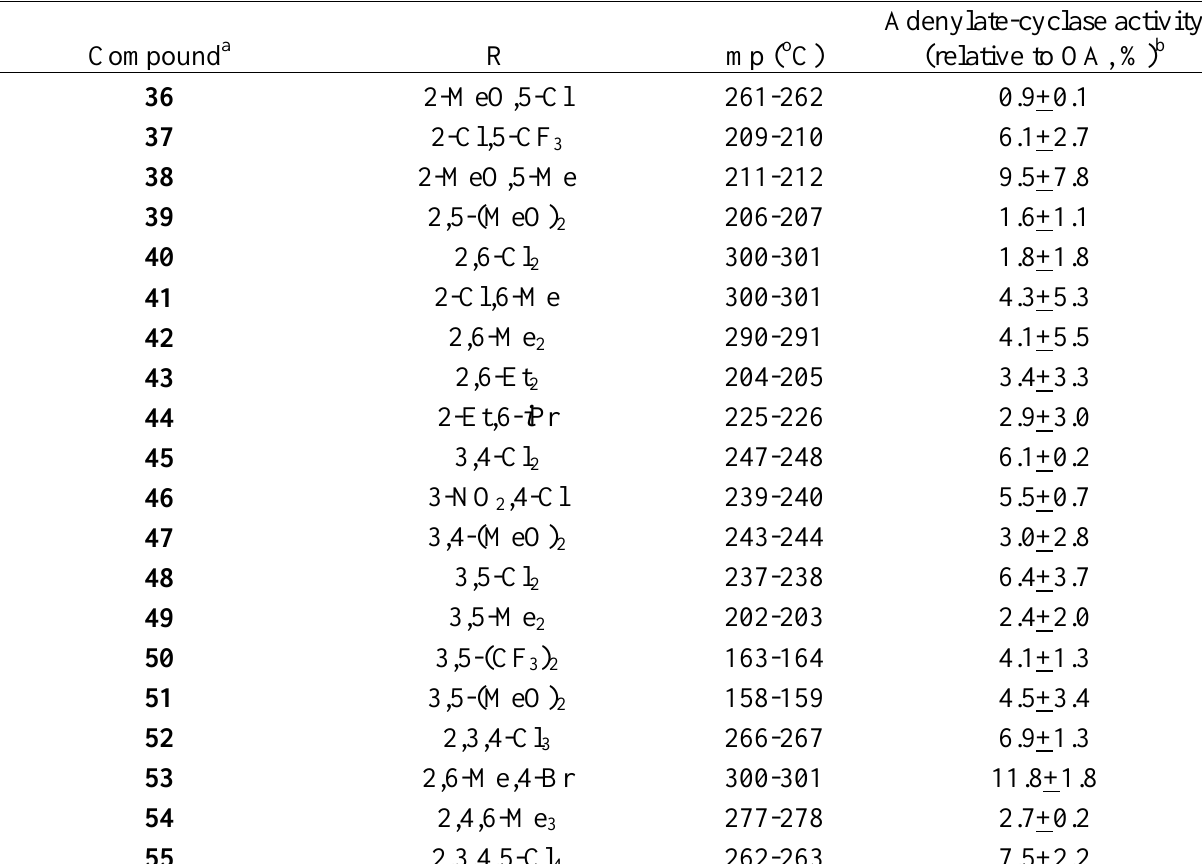
Table 1. OA agonist AIHTs used in this study